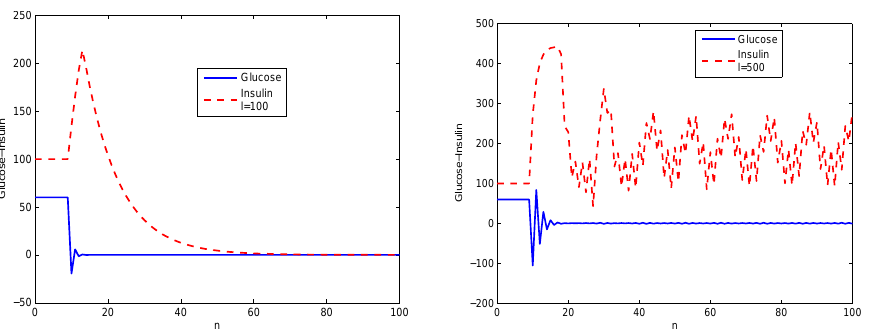
Fig. 2. Plots of the discretized model (18)–(19) with the step size l=0.1, l=66.6